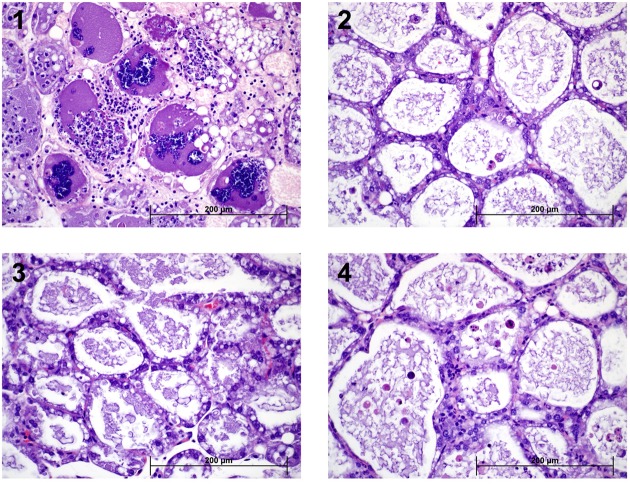
Histopathology. Representative H&E stained tissue sections from each group are shown. (1) Infected plus PBS treatment. Mouse mammary gland. Moderate to severe neutrophilic inflammation and bacterial colonization (dark purple) of mammary glands. The lining epithelium exhibits various stages of degeneration, necrosis and sloughing. (2) Infected plus cefalonium treatment. Healthy epithelial cells lining normal glandular tissue that contains a modest amount of flocculent proteinaceous secretion and rare sloughed necrotic or apoptotic cells. (3) Infected plus phage treatment. This image demonstrates healthy glandular epithelial cells characterized by robust cuboidal shape and a variable degree of clear cytoplasmic vacuolation (lipid). These cells are lining normal glandular tissue that contains a modest amount of flocculent proteinaceous secretion. (4) Uninfected plus phage. This gland is characterized by mild to moderate numbers of sloughed necrotic or apoptotic cells. The intact lining epithelium is otherwise normal.